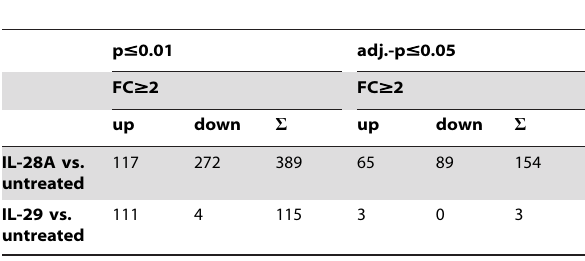
Table 2. Summary for the number of up- and down- regulated genes after 6 hours applying different stringency